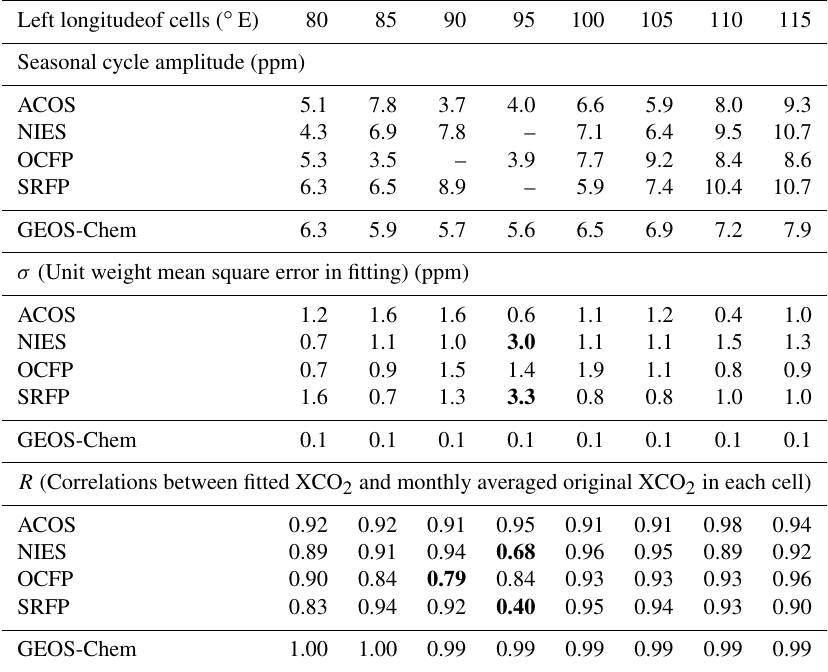
Table 6. Results of fitted seasonal cycle and the corresponding uncertainty of the fitting results for each cell in the study latitude band for four algorithms and GEOS-Chem, The symbols “–” means that filtered results are not available due to large uncertainty judged by R and σ . R , the correlation coefficient between fitted XCO 2 and monthly averaged original XCO 2 in each cell, less than 0.80, and σ , the unit weighted mean square error in fitting, not less than 3.0, are highlighted in